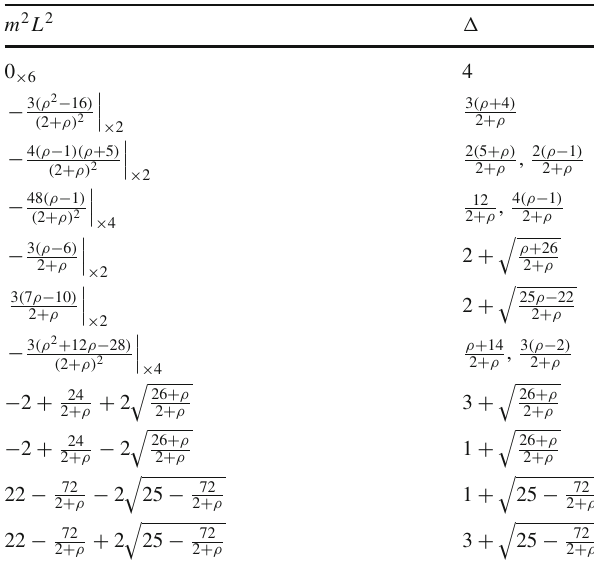
Table 4 Scalar masses at the N = 2 supersymmetric AdS 5 critical point IV with SO ( 2 ) diag symmetry and the corresponding dimensions of the dual